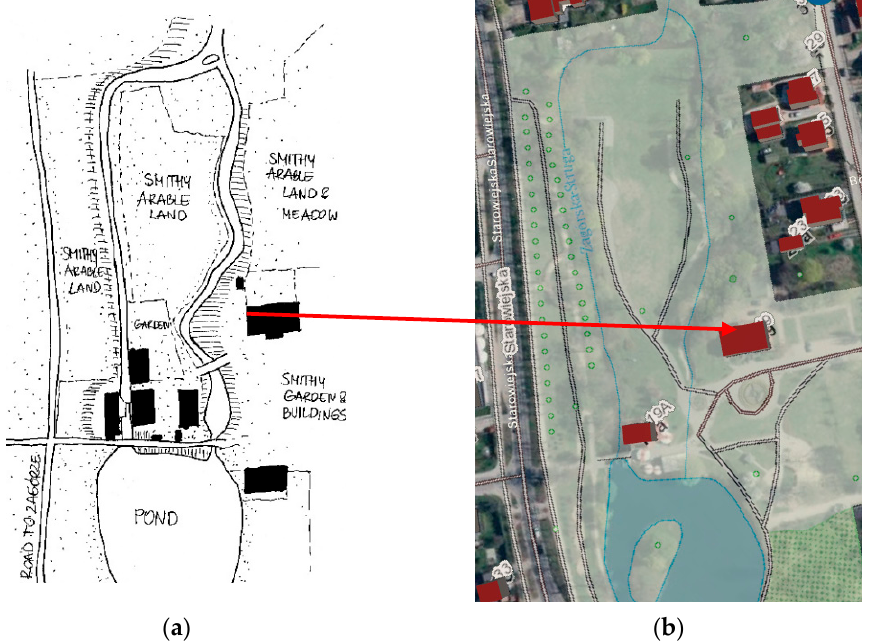
Figure 3. The case study area: ( a ) in the XIX century—a manor house from the second half of the 18th century, a residential house from the first half of the 19th century (demolished in the 1970s), a granary, a barn, a pigsty, and a stable next to Mickiewicza Street, and further away—a factory build- ing, a factory office, an oven, a farmhouse, and a pond designated as “public water” Source: author drawing, according to A. Sad ł owski [15] and historic map from 1829/66/664—Königl. Domänenren- tamta in Brück zu Zoppot, Wojewodzkie Archiwum Pa ń stwowe w Gda ń sku; ( b ) today—there is only one pond, designed to resemble historic watermills, orthophoto map, source: [18].